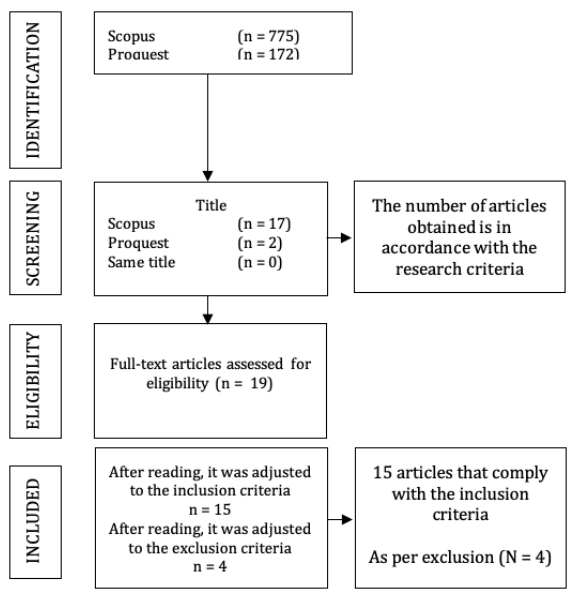
Table 1. Literature Search